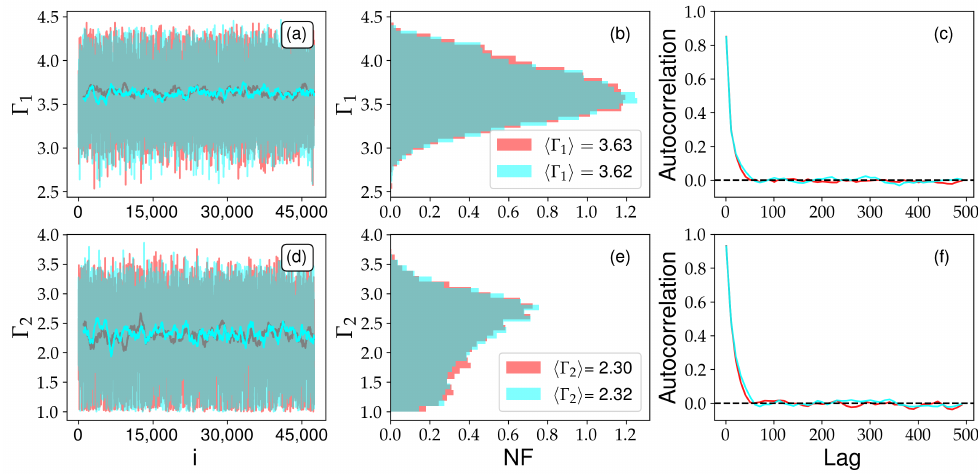
10 4 iterations. The deviation × 0.02, indicating that a small ≈